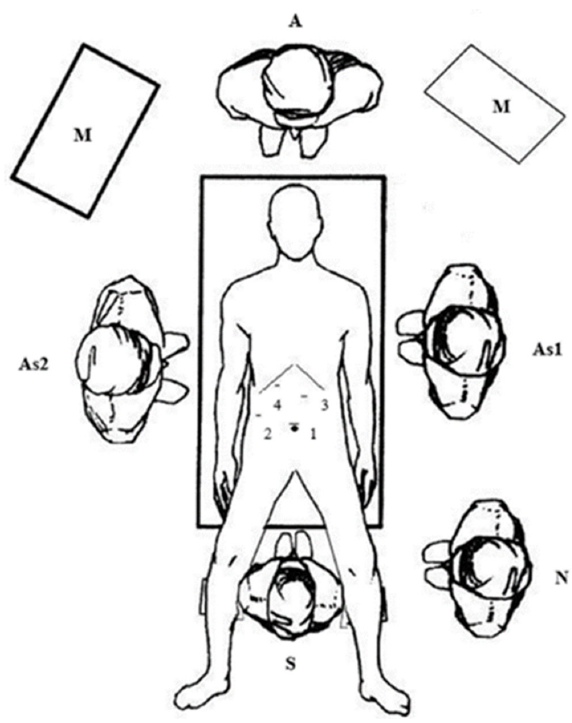
Figure 1. Trocar placement, position of the patient and operating staff. Legend: 1—the first 10-mm trocar; 2—the second 5-mm trocar; 3—the third (working) 10-mm trocar; 4—the fourth 5-mm trocar; S—operating surgeon; As1—the first assistant; As2—the second assistant; N—scrub nurse; A—anesthesia; M—monitor.